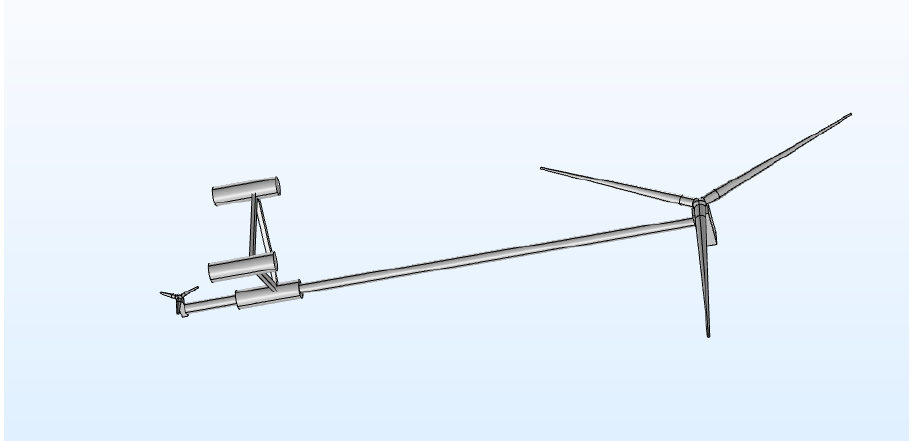
Figure 3. Structure drawn using the